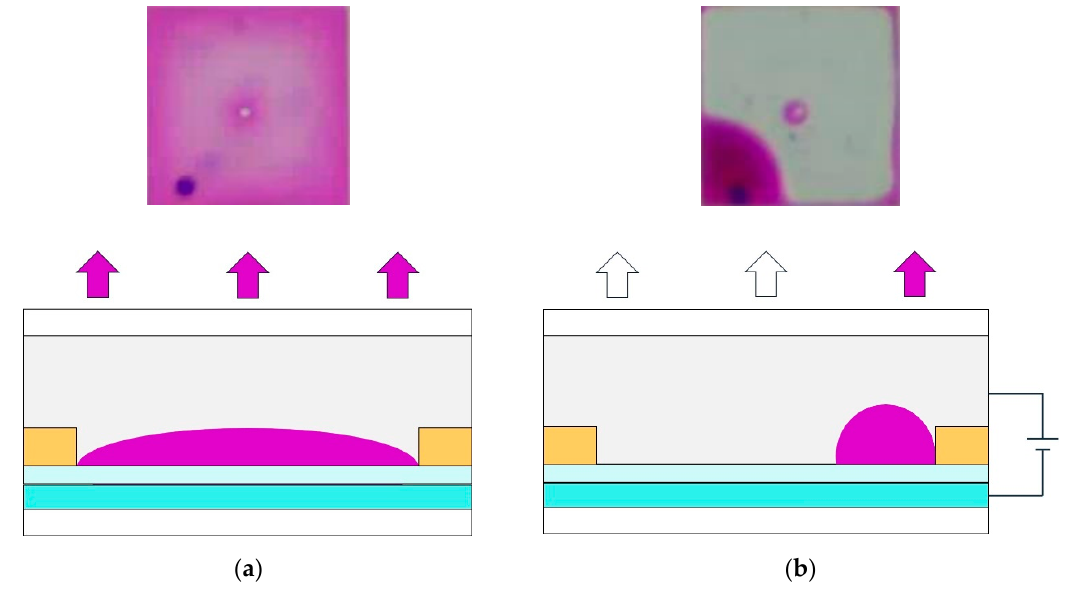
Figure 2. Ink state in an EWD pixel. ( a ) The pixel is “off” and the whole pixel is covered by ink such that the color of the ink is reflected. ( b ) The pixel is “on” and the ink is pushed into a corner of the pixel such that the white substrate is reflected.